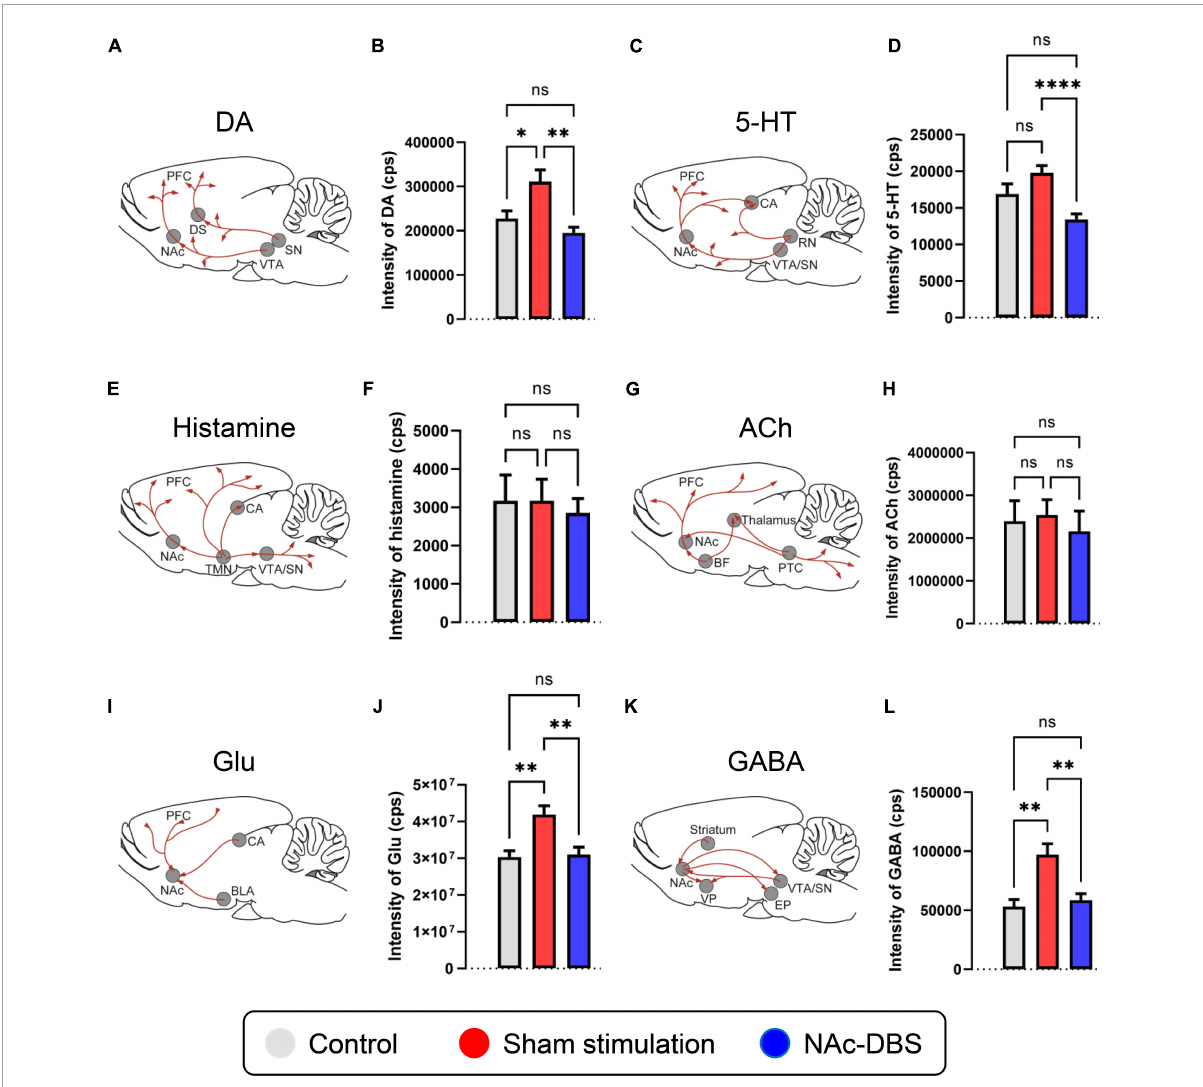
FIGURE1 Changes in the levels of neurotransmitters of interest in the NAc in the control, sham stimulation and NAc-DBS groups. (A) Illustration of dopaminergic projections to the NAc. (B) The bar graph represents the mean level of the response intensity indicating the concentration of DA in the NAc. (C) Illustration of serotonergic projections to the NAc. (D) The bar graph represents the mean level of the intensity of 5-HT in the NAc. (E) Illustration of histaminergic projections to the NAc. (F) The bar graph represents the mean level of the intensity of histamine in the NAc. (G) Illustration of cholinergic projections to the NAc. (H) The bar graph represents the mean level of the intensity of ACh in the NAc. (I) Illustration of glutamatergic projections to the NAc. (J) The bar graph represents the mean level of the intensity of Glu in the NAc. (K) Illustration of the GABAergic pathway in the NAc. (L) The bar graph represents the mean level of the intensity of GABA in the NAc. All illustrations are modified from the stereotaxic atlas of Paxinos and Watson (6th edition). DA, dopamine; VTA, ventral tegmental area; 5-HT, serotonin; RN, raphe nuclei; TMN, tuberomammillary nucleus; ACh, acetylcholine; BF, basal forebrain; PTC, pontomesencephalo-tegmental complex; Glu, glutamate; BLA, basolateral amygdala; CA, hippocampus; GABA, gamma-aminobutyric acid; VP, ventral pallidum; SN, substantia nigra; EP, entopeduncular nucleus. The data are presented as the mean ± SEM; n = 11 vs. n = 23 vs. n = 21; ∗∗∗∗ P < 0.0001, ∗∗ P < 0.01, ∗ P < 0.05; ns, no